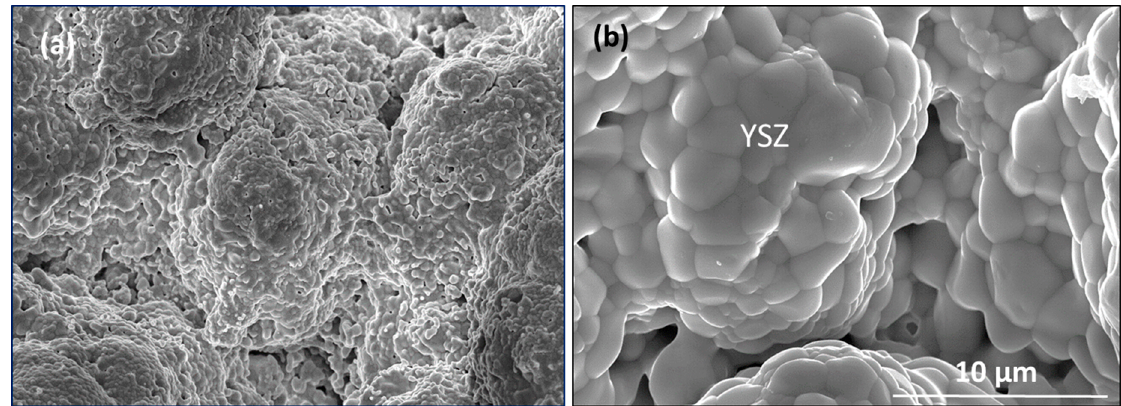
Figure 9. SEM microstructure of YSZ coating surface on Ti 2 AlC after the Mach 0.3 high velocity burner rig test. ( a ) Grip end, 500 h / 1200 ◦ C test, ( b ) hot zone, 500 h / 1300 ◦ C